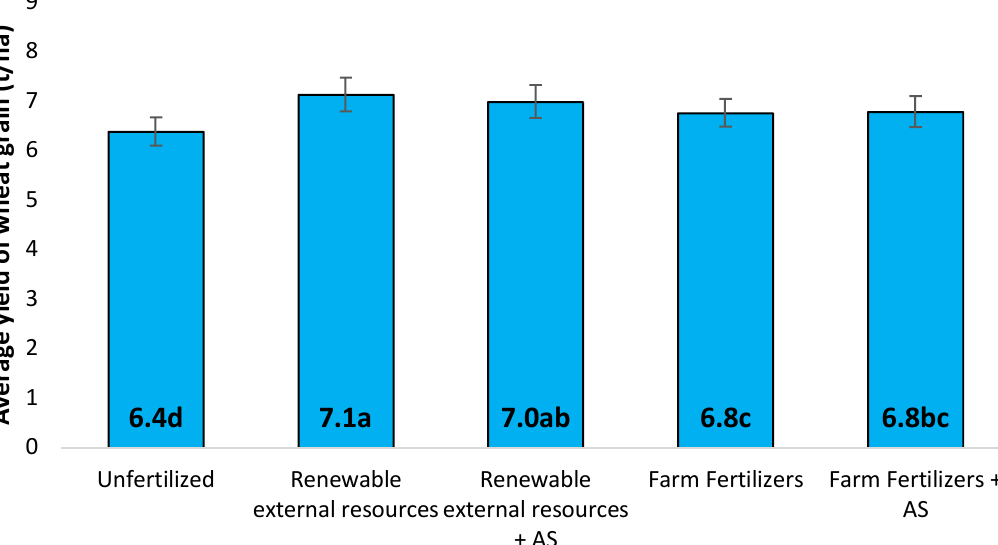
Figure 1. Grain yield of winter wheat (observed treatments, 2015). Error bars represent the standard error (SE). Different letters mean statistical difference ( p ≤ 0.5).